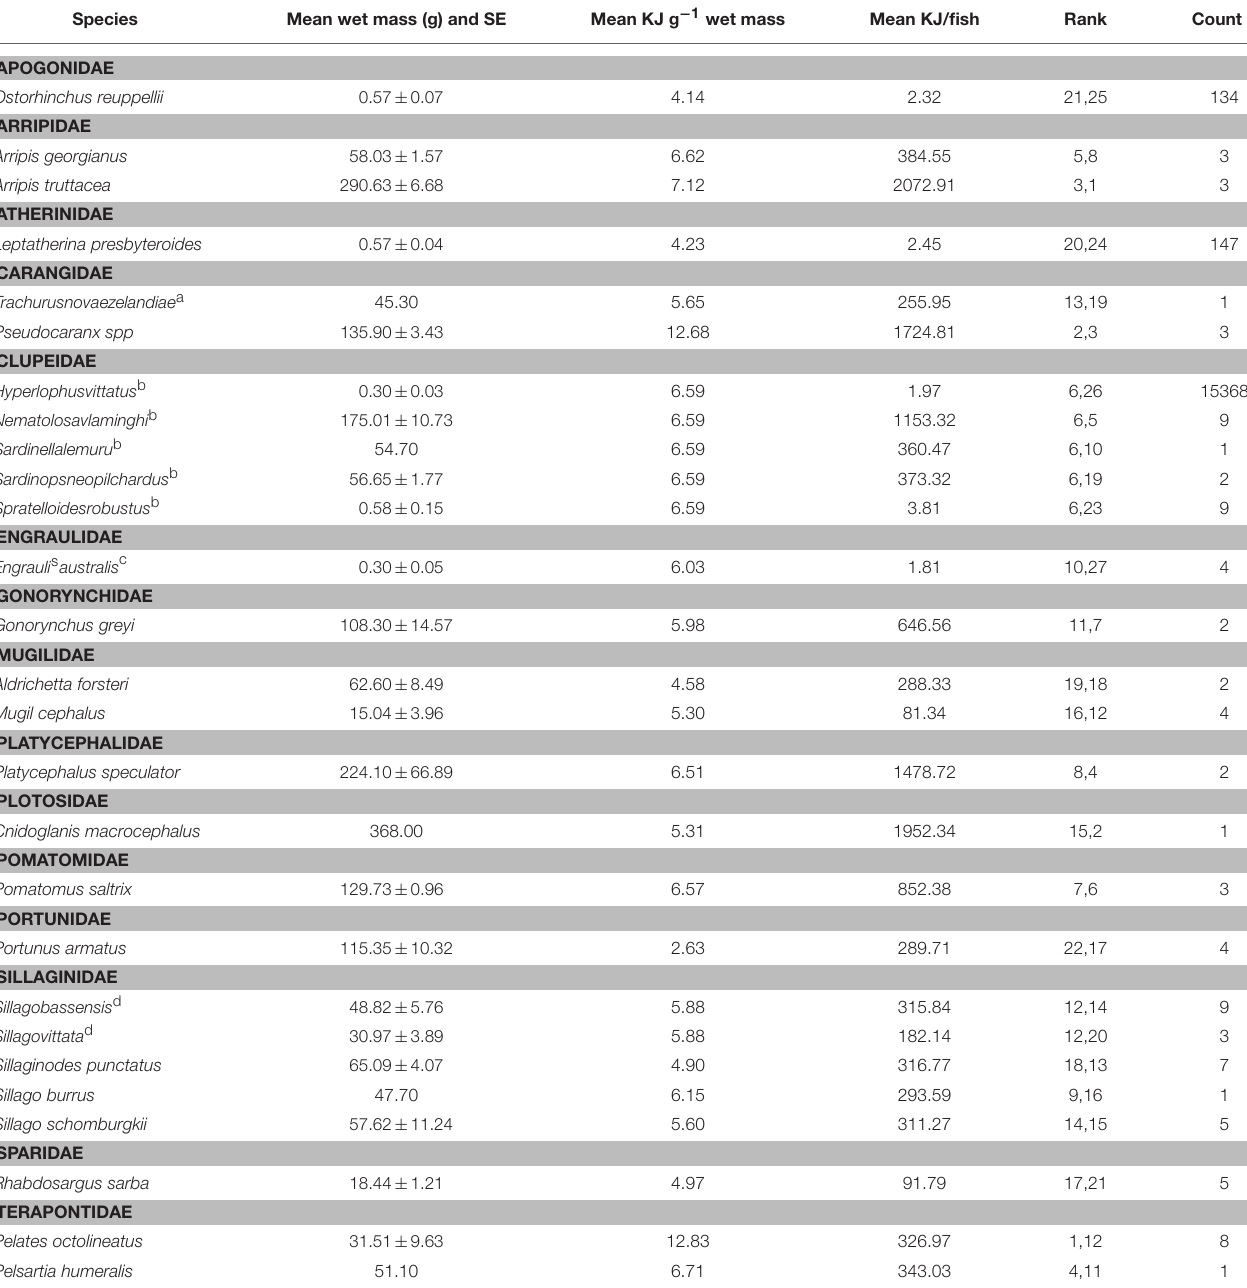
TABLE 9 | Summary of energy values of fish in each family caught in the Estuary, Bay, and Ocean of the Bunbury region. Species Mean wet mass (g) and SE Rank